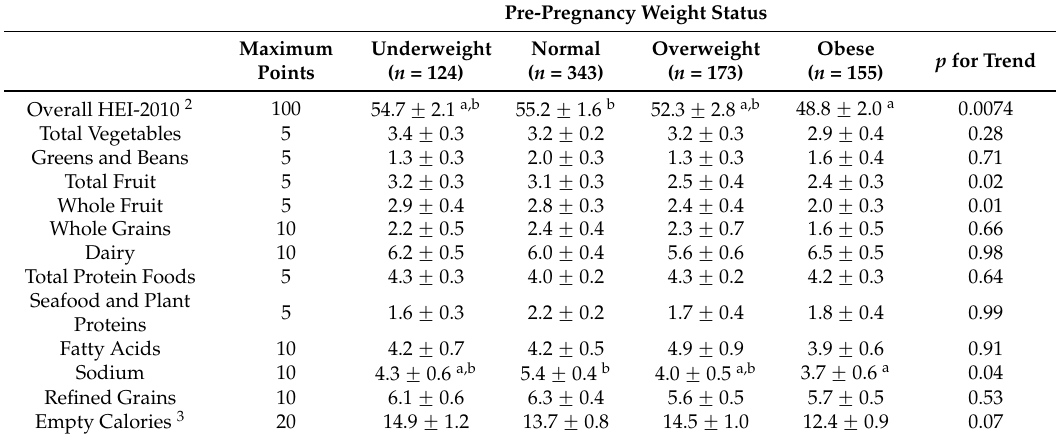
Table 3. The Healthy Eating Index (HEI)-2010 scores 1 across categories of pre-pregnancy weight status ( n =